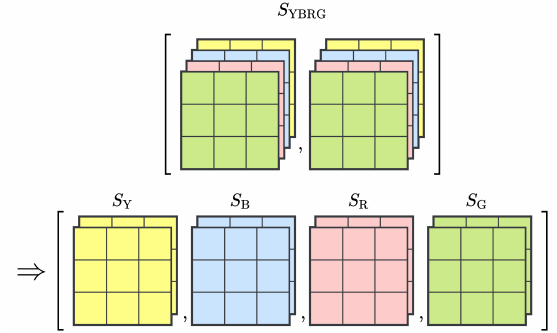
Figure 5. In the first layer of the 3D-CNN, the sequences of multi-layer input data are handled layer-wise. This helps the model first learn layer-wise spatio-temporal features, which are then composed as interlayer spatio-temporal features in the subsequent